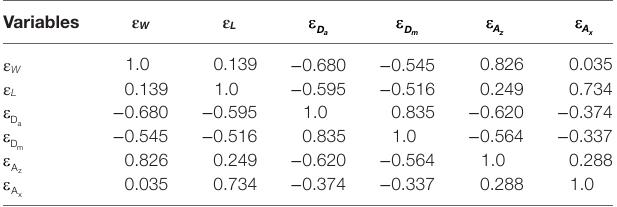
TaBle 2 | Linear correlation coefficients of regression residuals of the scaling relationships for the six earthquake source